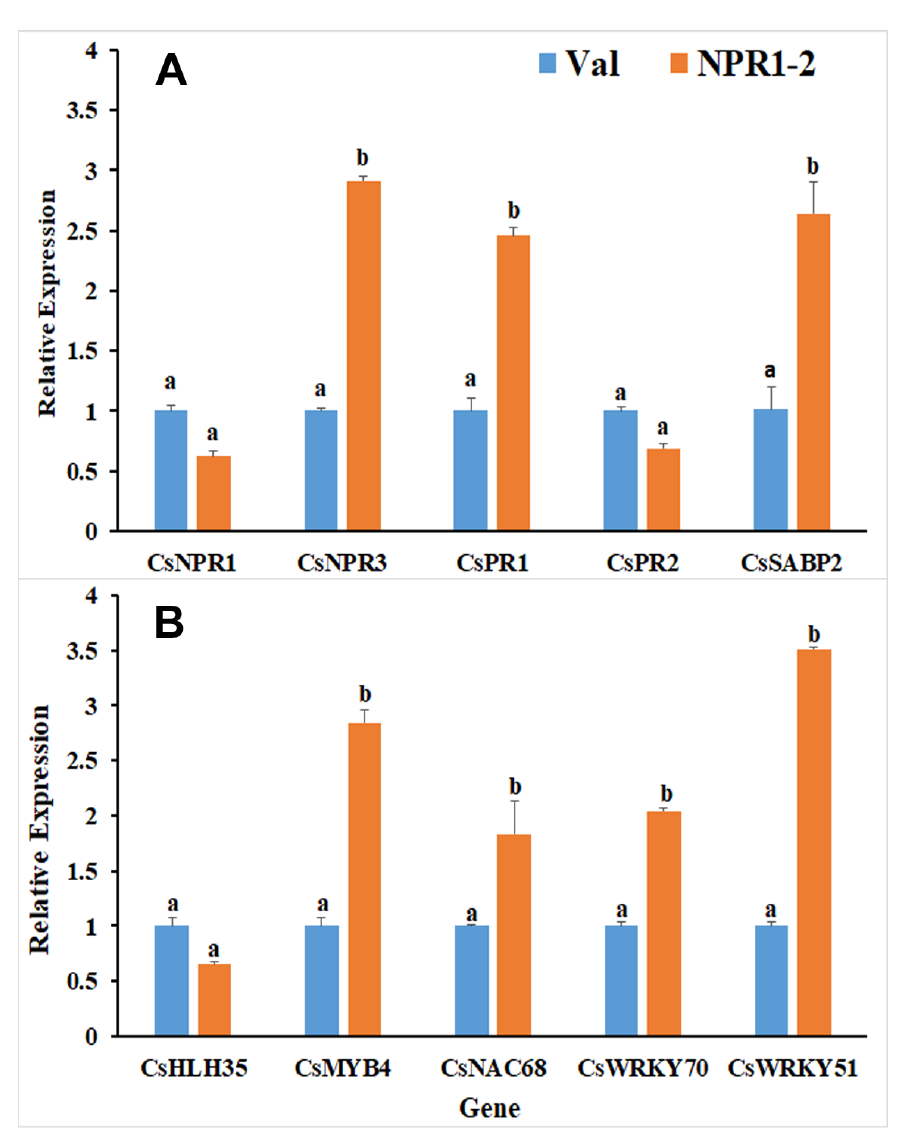
Figure 5. qRT-PCR for RNAseq data validation of genes involved with plant defense responses. Comparison between NPR1-2 transgenic and non-transgenic plants of genes involved in the ( A ) NPR1-SA dependent pathway, including CsNPR1, CsNPR3, and CsSABP2 along with pathogenesis related proteins, CsPR1 and CsPR2; and ( B ) transcription factors. Different letters (a, b) represent a significant difference at p ≤ 0.05 using Duncan’s Multiple Range Test and error bars represent SE ( n = 3).